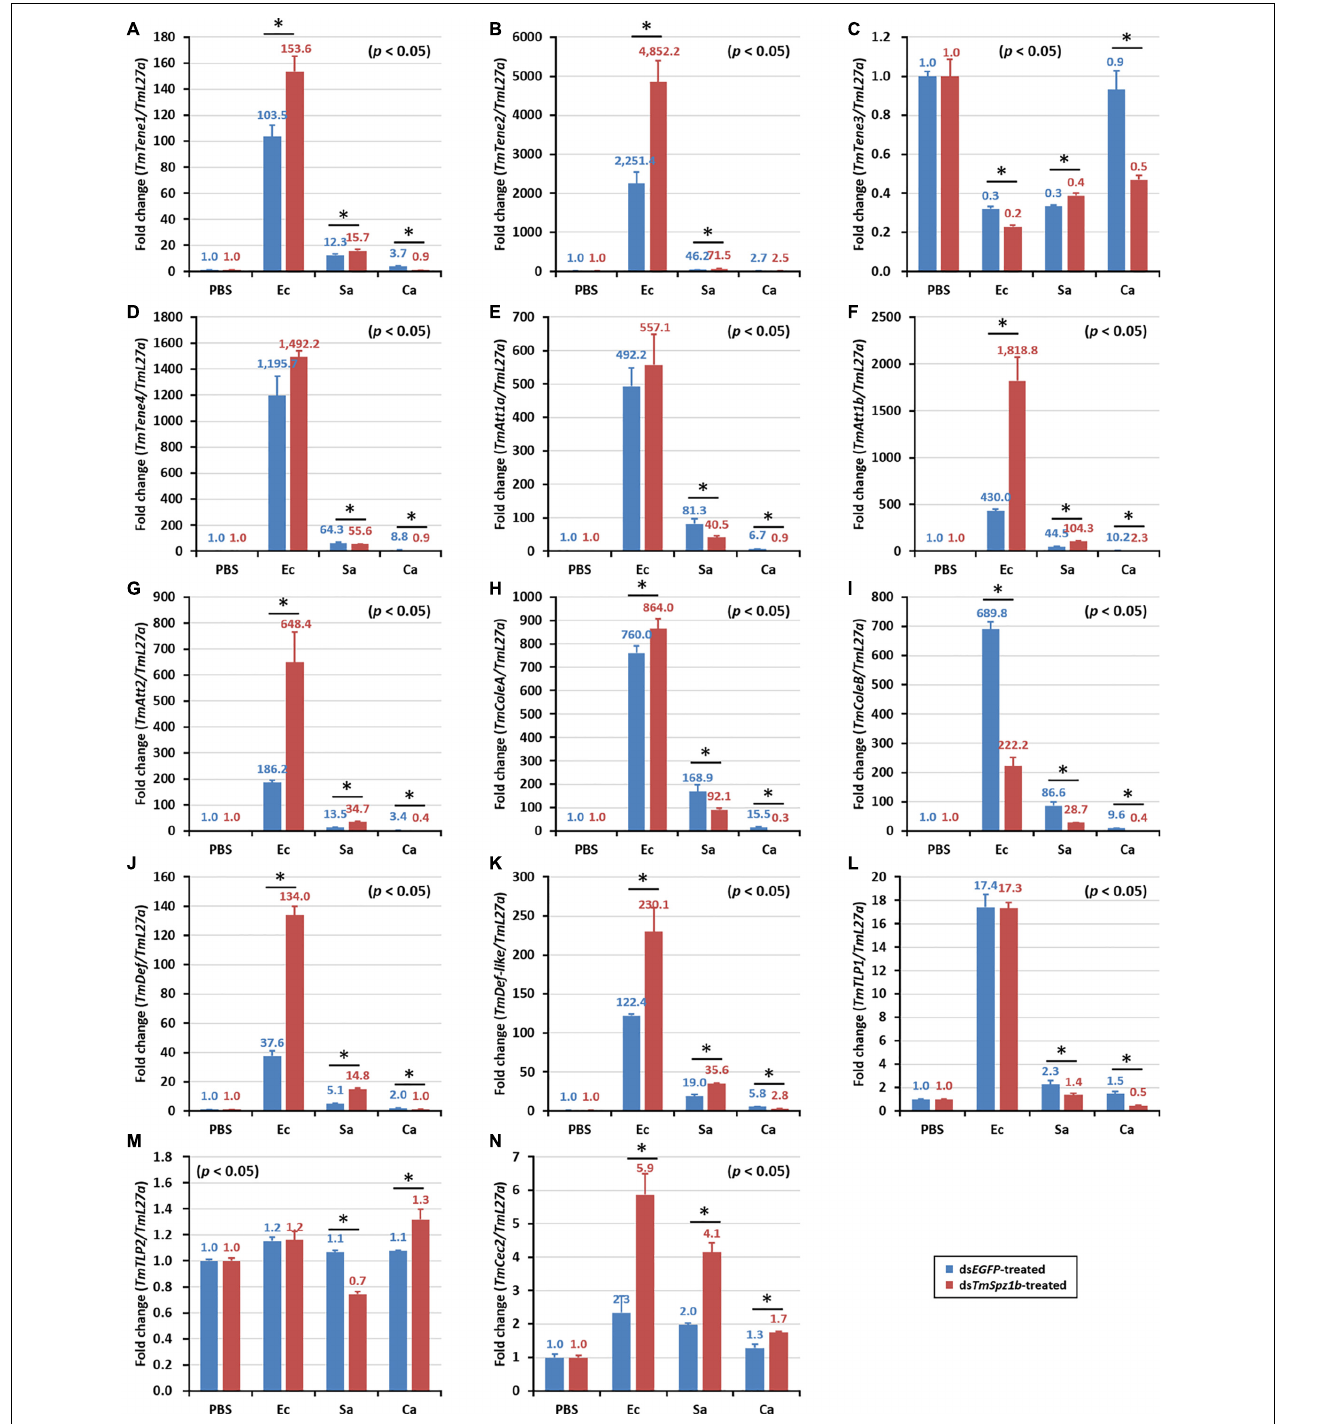
FIGURE 8 | Effects of TmSpz1b gene-silencing on the expression of 14 AMP genes in response to pathogen injection in the gut. E. coli, S. aureus, and C. albicans were injected into ds TmSpz1b -treated T. molitor larvae. The expression levels of 14 AMP genes were determined at 24-post injection, by qRT-PCR. In the gut, only one AMP gene ( TmColeoptericin2 ) was significantly decreased by TmSpz1b RNAi. dsEGFP was injected as a negative control, and TmL27a was used as an internal control. All experiments were performed in triplicate. Asterisks indicate significant differences between ds TmSpz1b and ds EGFP -treated groups when compared by Student’s t -test ( P < 0.05). TmTene1 ( A ; TmTeneecin-1 ), TmTene2 ( B ; TmTenecin-2 ). TmTene3 ( C ; TmTenecin-3 ), TmTene4 ( D ; TmTenecin-4 ), TmAtt1a ( E ; TmAttacin-1a ), TmAtt1b ( F ; TmAttacin-1b ), TmAtt2 ( G ; TmAttacin-2 ), TmCole1 ( H ; TmColeoptericin-1 ), TmCole2 ( I ; TmColeoptericin-2 ), TmDef1 ( J ; TmDefensin-1 ), TmDef2 ( K ; TmDefensin-2 ), TmTLP1 ( L ; TmThaumatin-like protein-1 ), TmTLP2 ( M ; TmThaumatin-like protein-2 ), TmCec2 ( N ; TmCecropin-2 ).